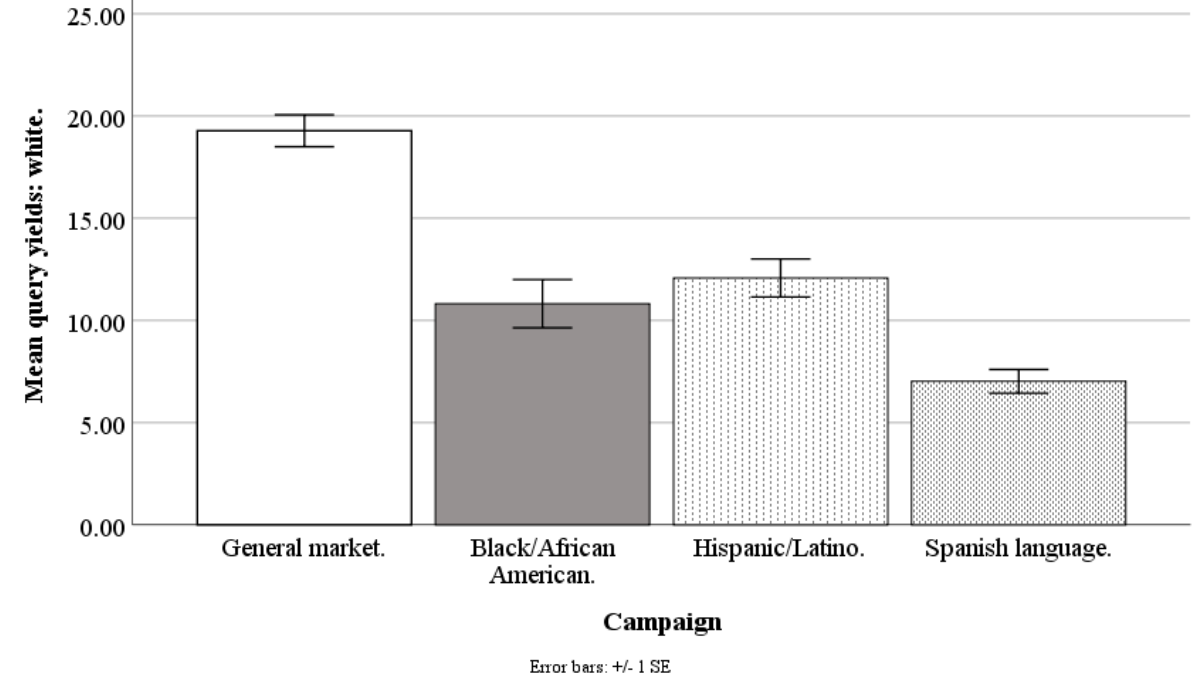
Figure 1. Mean query yields of whites for Facebook advertising